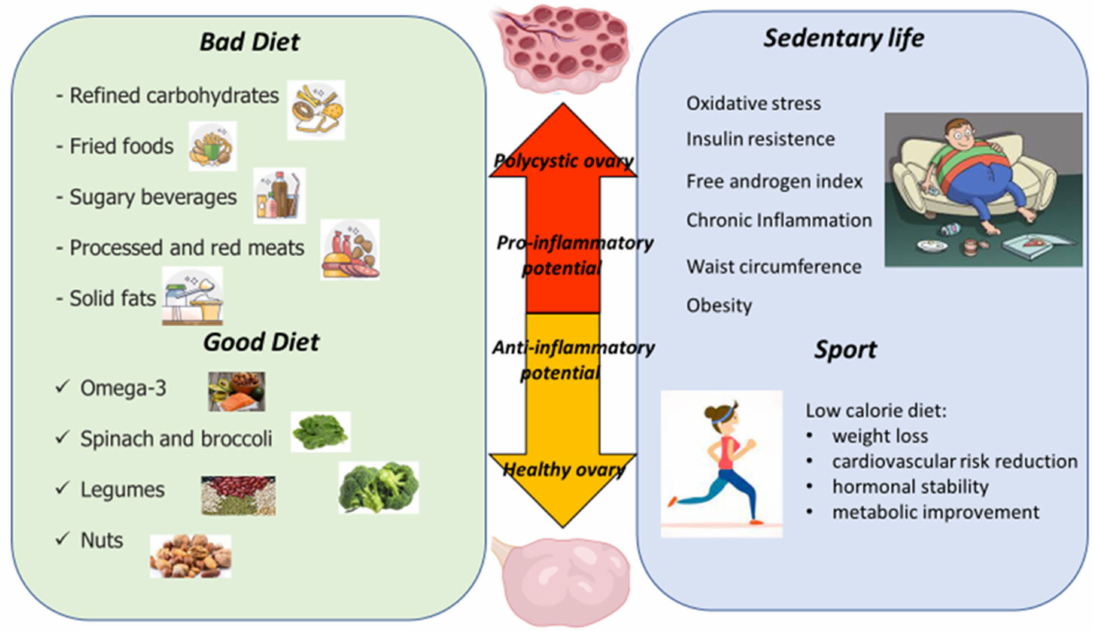
Figure 2. The influence of diet and physical activity on inflammation and ovarian